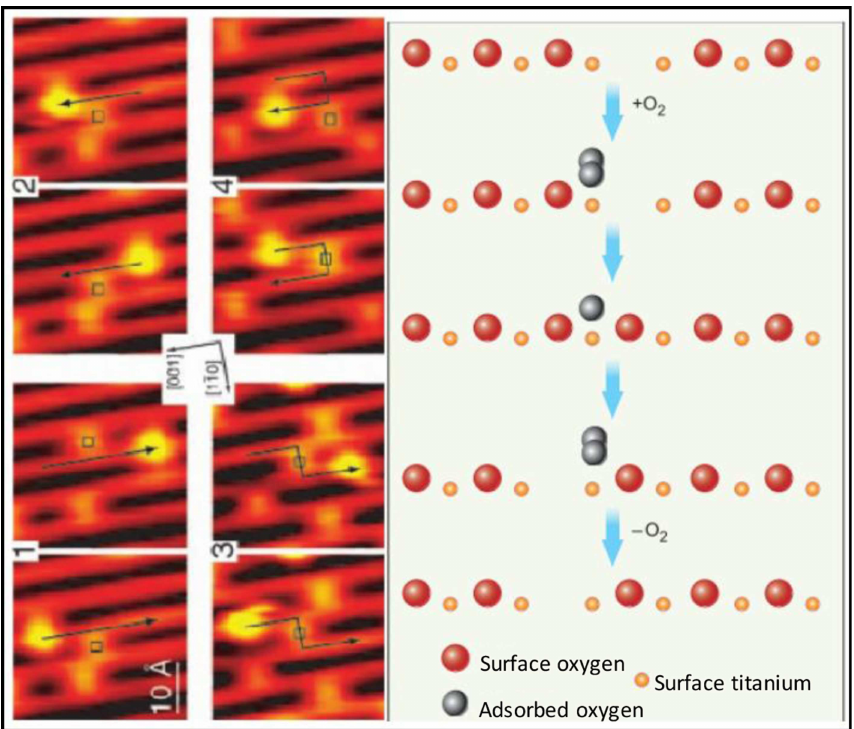
Figure 1. Scanning tunneling microscopic (STM) images ( left ) and molecular schematics ( right ) demonstrate the interactions of molecular oxygen adsorbed to the surface of titanium oxide at the site of oxygen vacancies within the crystal structure of the metal oxide. Each adjacent STM image shows the surface structure of the metal oxide before and after the interaction with molecular oxygen and the migration of the oxygen vacancy. Used with permission from Pinto et al.